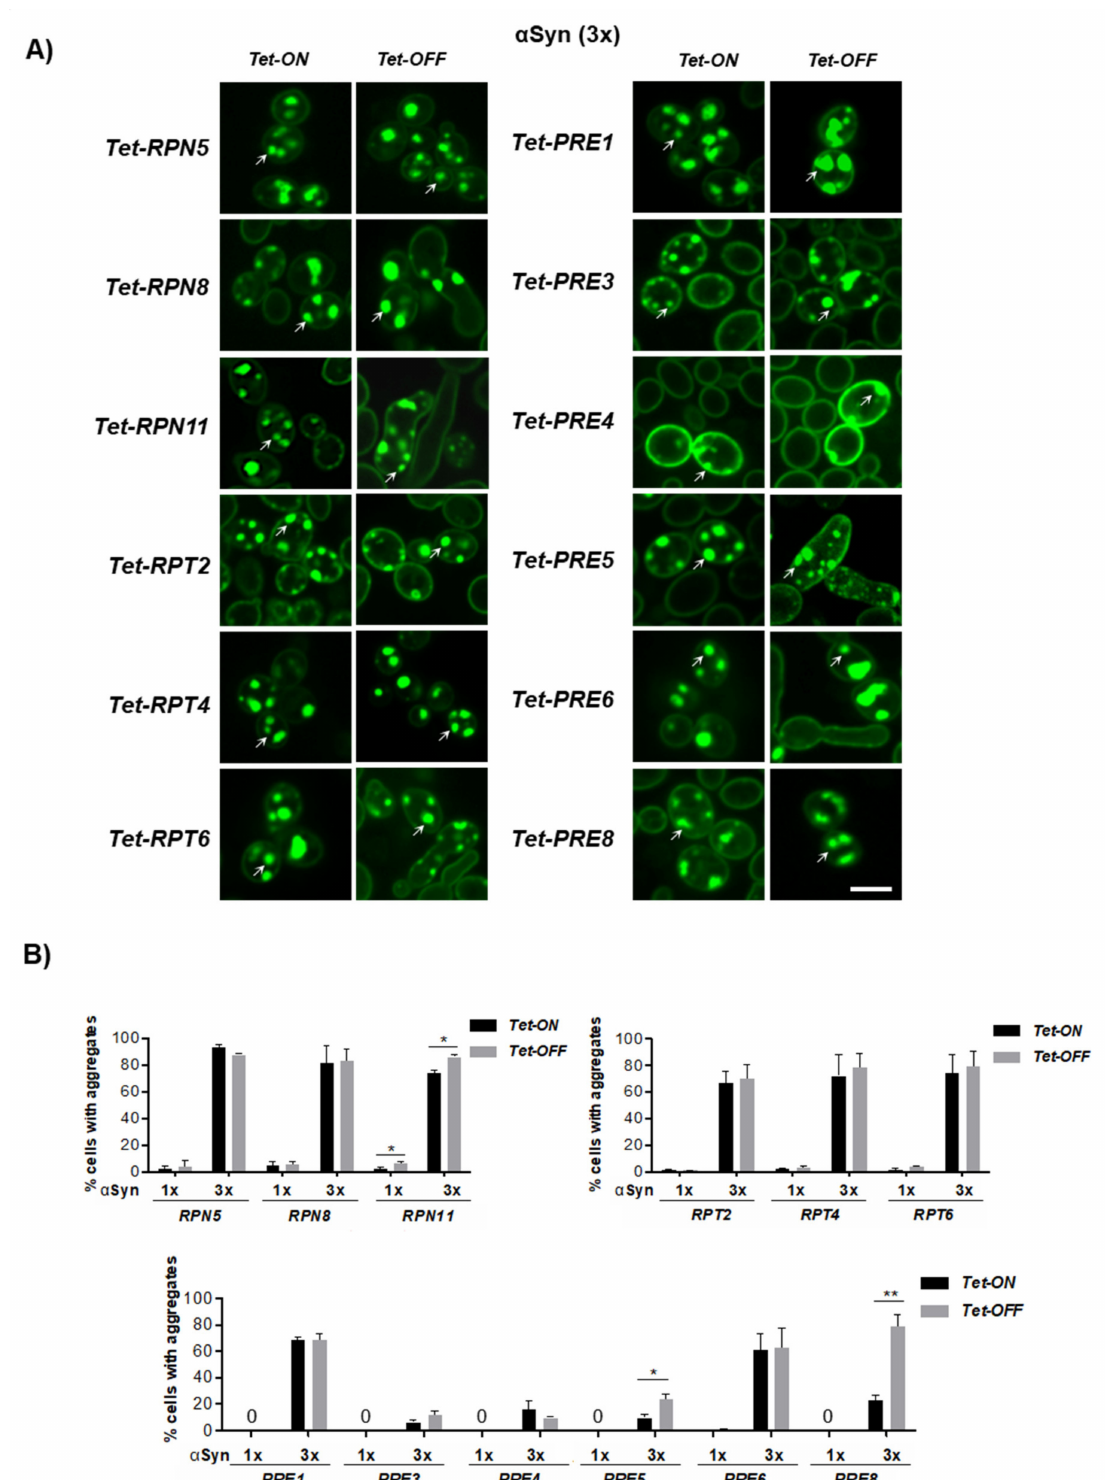
Figure 6. Inclusion formation of α Syn upon downregulation of the proteasome gene expression. ( A ) Fluorescence microscopy of yeast cells expressing α Syn-GFP from three gene copies in strains with Tet alleles of proteasome genes after 16 h induction in a galactose-containing medium. Tet promoter was downregulated by addition of 10 µ g/mL doxycycline to the growth medium simultaneously with the induction of α Syn expression. Intracellular inclusions are marked with arrows. Scale bar = 5 µ m. ( B ) Quantification of the percentage of cells displaying α Syn-GFP inclusions. “0” indicates cells without inclusion. The significance of the differences was determined with a t -test (*, p < 0.05; **, p < 0.01; n =